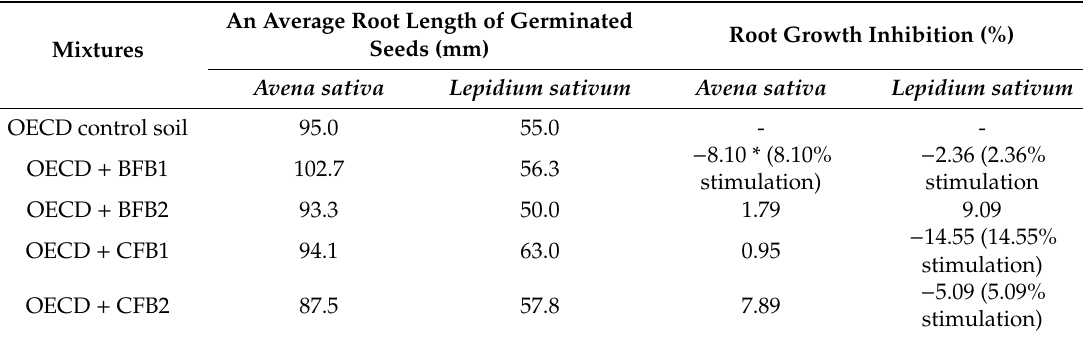
Table 5. An average root length of the germinated